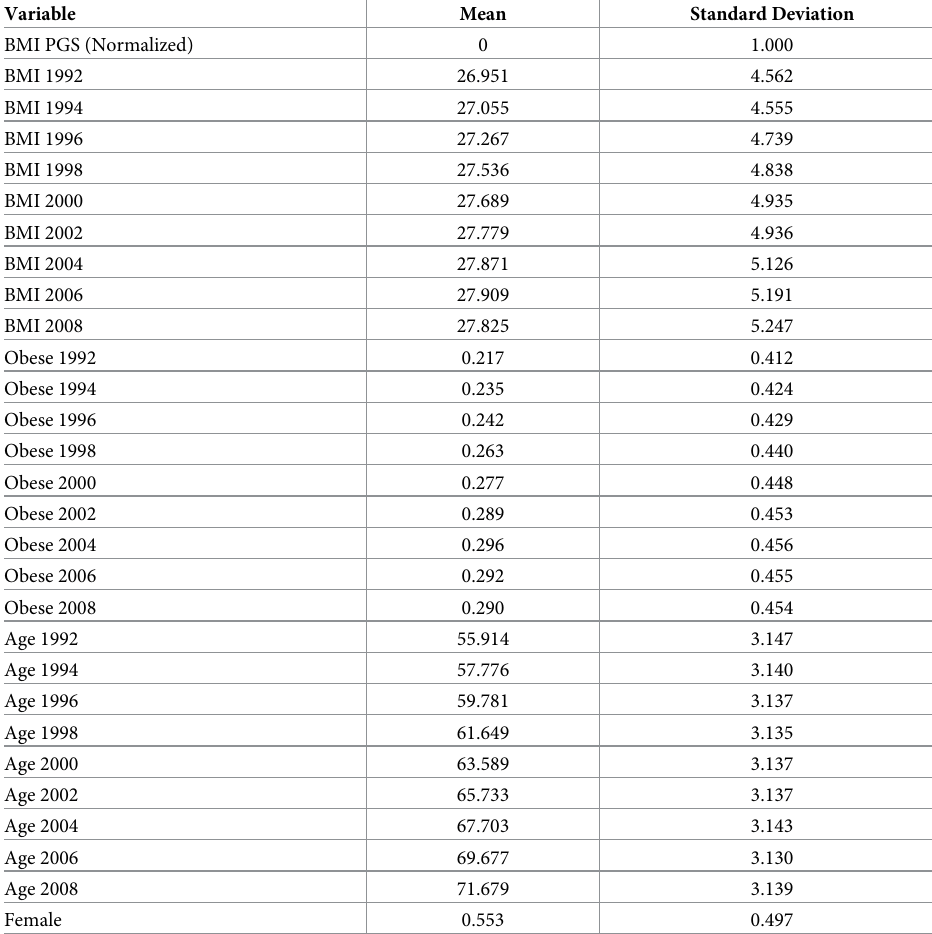
Table 1. Summary statistics. HRS Original Cohort